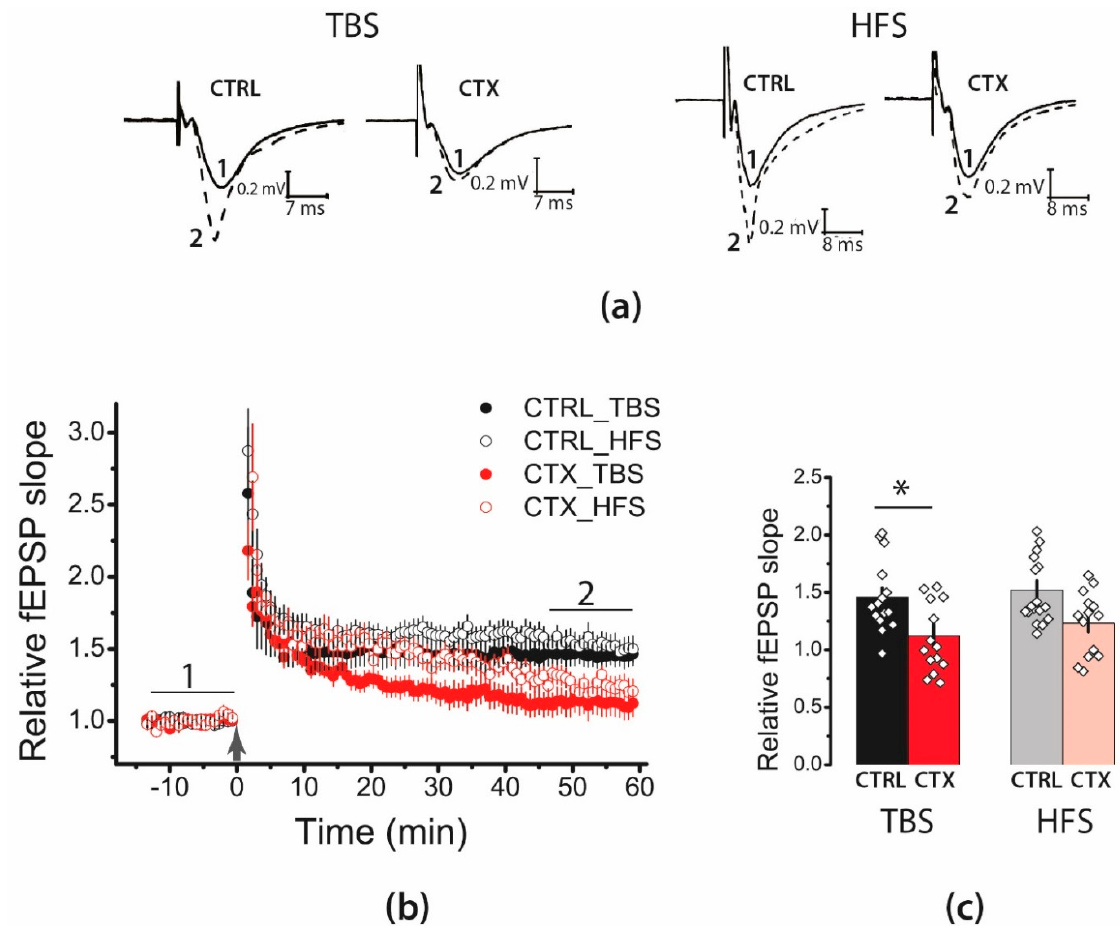
Figure 1. Long-term potentiation (LTP) was attenuated in the CA1 hippocampal area after administration of ceftriaxone (CTX). ( a ) Representative examples of field excitatory postsynaptic potential (fEPSP) before induction (1) and 60 min after theta-burst stimulation (TBS) or high-frequency stimulation (HFS) (2). ( b ) Diagram showing changes in the value of the normalized slope of fEPSP in the control (CTRL) and CTX-treated (CTX) animals after TBS or HFS. Black arrow indicates the moment of LTP induction (TBS or HFS). ( c ) Diagram illustrating the differences in LTP between the control and CTX-treated (CTX) animals according to the type of induction protocol. All the data are presented as mean ± standard error of the mean. * p < 0.05: a significant difference versus the control group ('Tukey’s post hoc test).